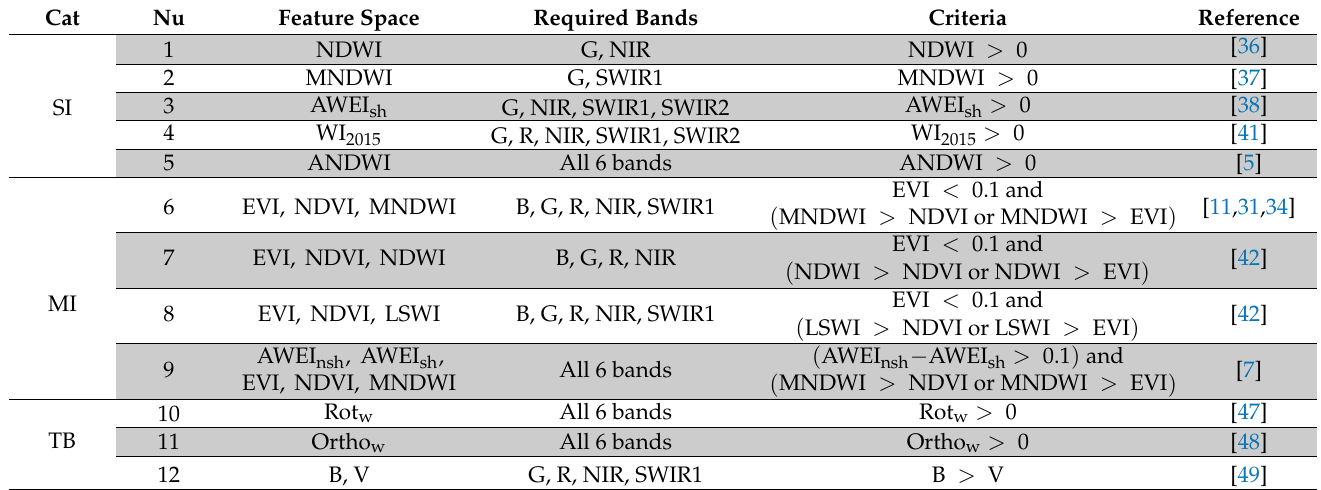
Table 2. Water Mapping Rules